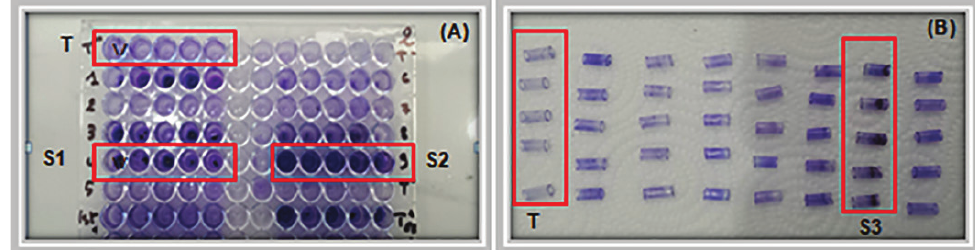
FIGURE 2 - Adhesion test of bacterial strains on a 96-wells microplate (A) and on a catheter